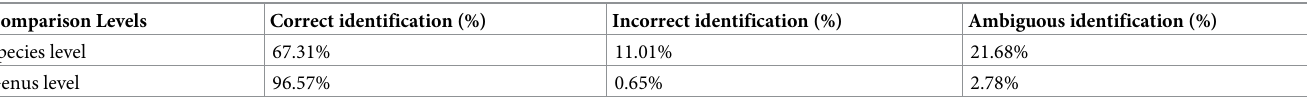
Table 3. Identification success rates of ITS2 through the BLAST